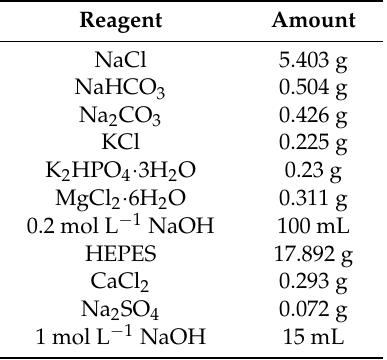
Table 1. Amounts of reagents for the preparation of 1000 mL solution of the simulated body fluid (SBF), adopted from Oyane et al.